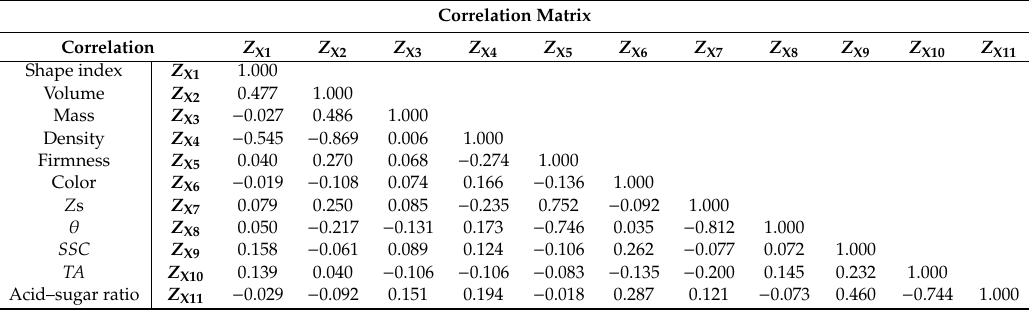
Table 1. Correlation analysis results for eleven normalized indicators measured in fresh peaches. SSC—soluble solid concentration; TA—titratable